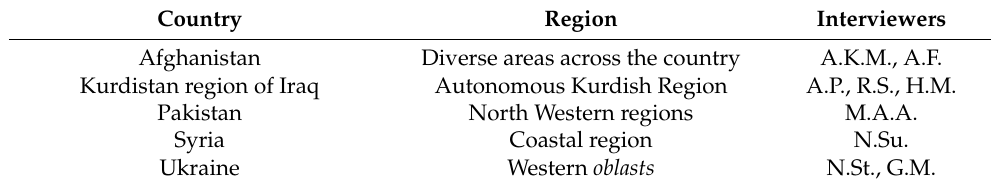
Table 1. The case studies conducted on wild food plants in five Eurasian countries. Country Region Interviewers Afghanistan Diverse areas across the country A.K.M., A.F. Kurdistan region of Iraq Autonomous Kurdish Region Pakistan North Western regions